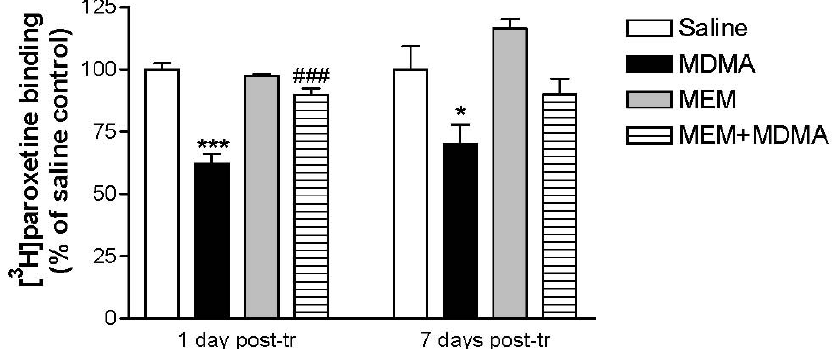
Figure 6. Prevention by memantine of the loss of serotonergic terminals induced by MDMA [89]. Dark Agouti rats were treated with a neurotoxic dose of MDMA plus/minus memantine (MEM) and killed 1 or 7 days after. [ 3 H]paroxetine binding was performed in hippocampal membranes. ANOVA: * P < 0.05, *** P < 0.001 vs . saline; ### P < 0.001 vs .